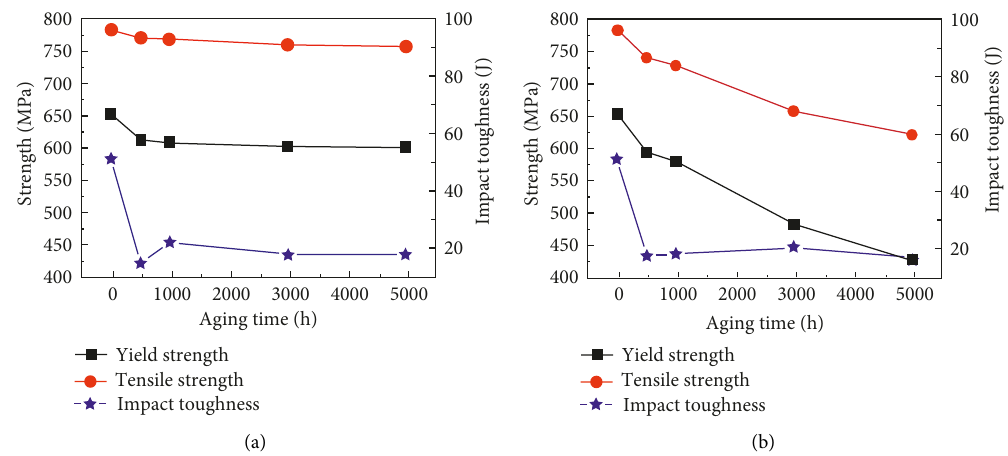
Figure 7: Room-temperature mechanical properties of G115 steel as a function of aging time at (a) 650 ° C and (b) 700 °